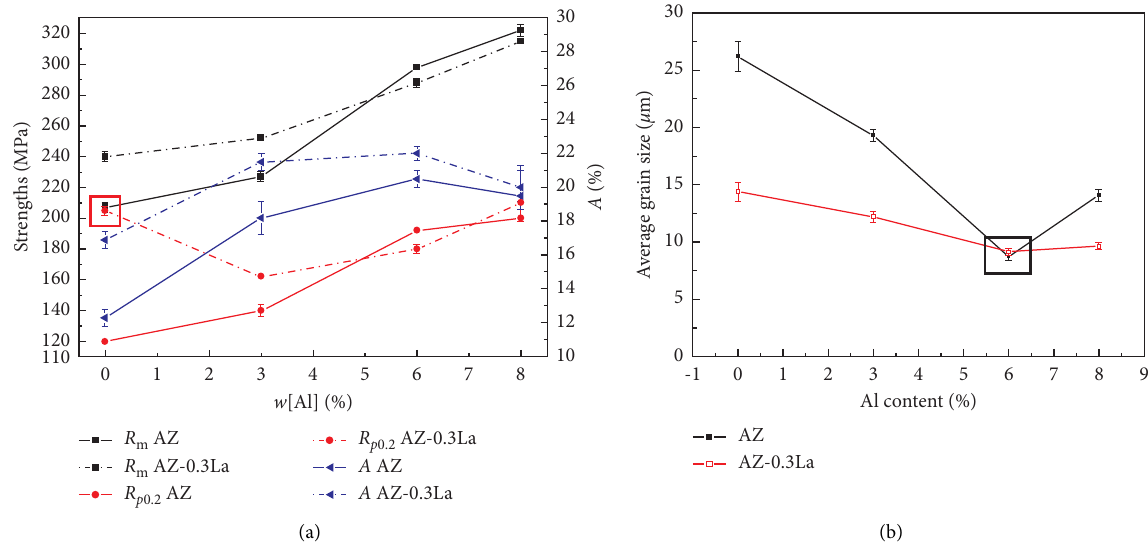
Figure 5: Tensile properties and the relationship between the average grain size and Al content of as-extruded AZ and AZ-0.3La alloys: (a) Property and (b) relationship.